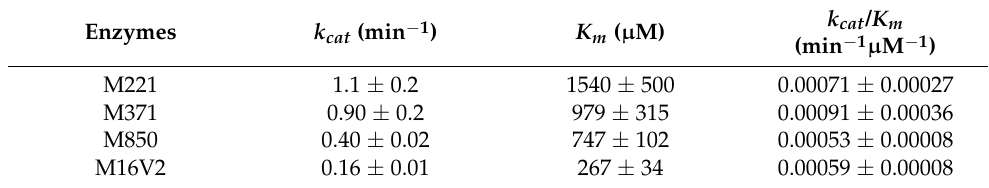
Table 1. Steady-state kinetics of the formation of 3-OH phlorizin from phlorizin using CYP102A1 mutants.